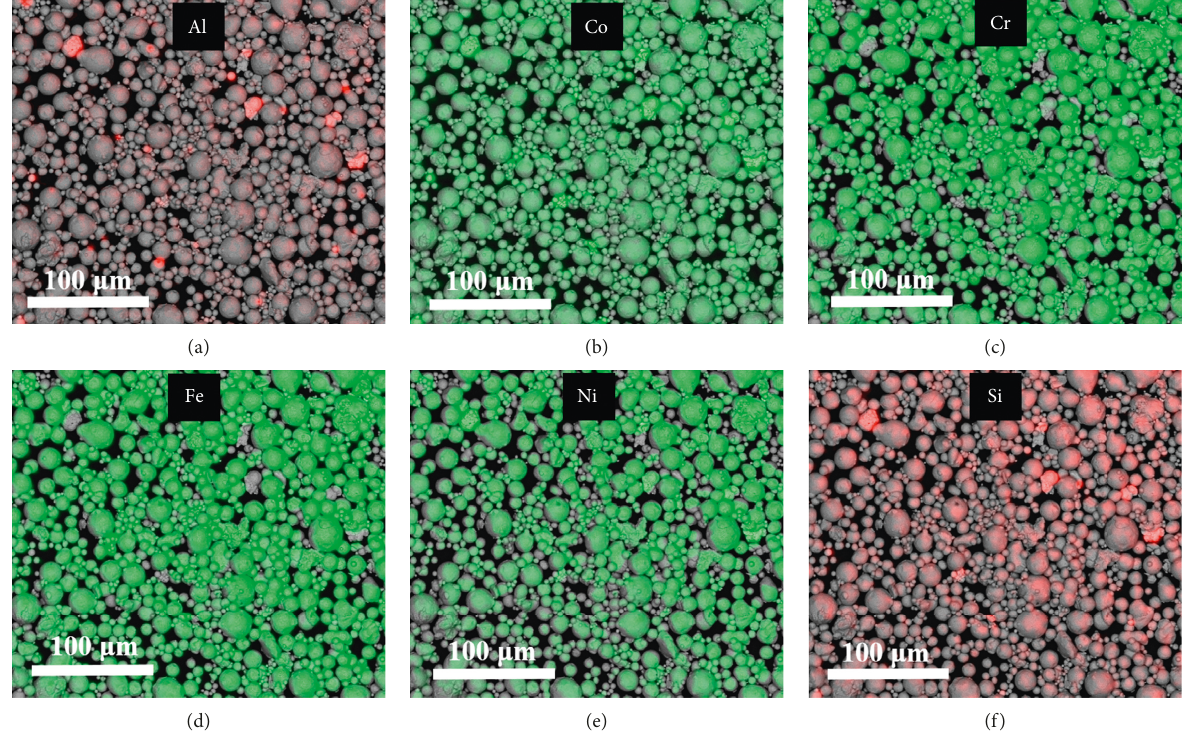
Figure 6: EDS chemical composition mapping of the used IN718 powder.